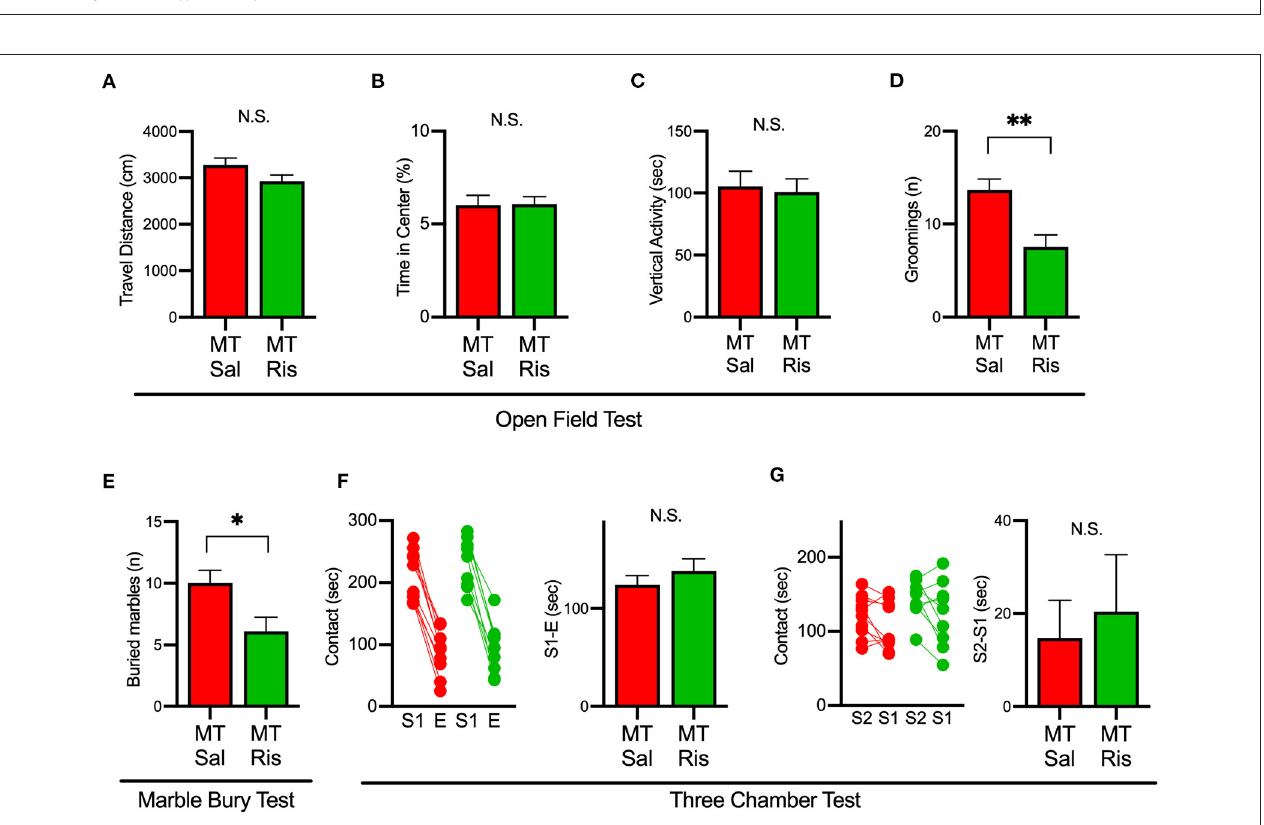
FIGURE 5 | frequency of mEPSCs were shown in the graph. The frequency of mEPSCs was decreased in risperidone-injected SIK1-MT mice. (C) , Cumulative distribution and the mean values of the amplitude of mEPSCs were shown in the graph. The amplitude of mEPSCs was unchanged between saline- and risperidone-injected SIK1-MT mice. (D) Representative traces of mIPSC recorded from the layer 5 pyramidal neurons in mPFC of saline (Sal)- and risperidone (Ris)-injected SIK1-MT mice were shown. (E) Cumulative distribution of the inter-event intervals and the mean values of the frequency of mIPSCs were shown in the graph. (F) Cumulative distributions and mean values of the amplitude of mIPSCs were shown in the graph. (G) The scatter plot shows the relationship between the frequencies of mIPSC (x-axis) and mEPSC (y-axis). Each dot represents a single neuron from saline- or risperidone-injected SIK1-MT mice. (H) E/I balance index of saline (Sal)- and risperidone (Ris)-injected SIK1-MT mice is shown. E/I balance is unchanged between saline- and risperidone-injected SIK1-MT mice. (I–K) Resting membrane potential (I) , input resistance (J) , membrane capacitance (K) of pyramidal neurons in layer 5 of mPFC of saline (Sal)- and risperidone (Ris)-injected SIK1-MT mice. (L–N) half-peak width (L) , rise time (M) , and decay time (N) of the action potential of the pyramidal neurons in layer 5 of the mPFC of saline (Sal)- and risperidone (Ris)-injected SIK1-MT mice. (O) Representative traces of induced action potentials responded to 240pA injected currents. (P) Graph for the relationship between spike frequency and injected current. Spike frequency of the action potential was decreased in risperidone-injected SIK1-MT mice. The numbers of neurons and mice used in each analysis are shown on the bar (neurons/mice) in the graphs. Statistical analysis was made by Student’s t -test. Statistical significance was indicated by asterisks (* p < 0.05).